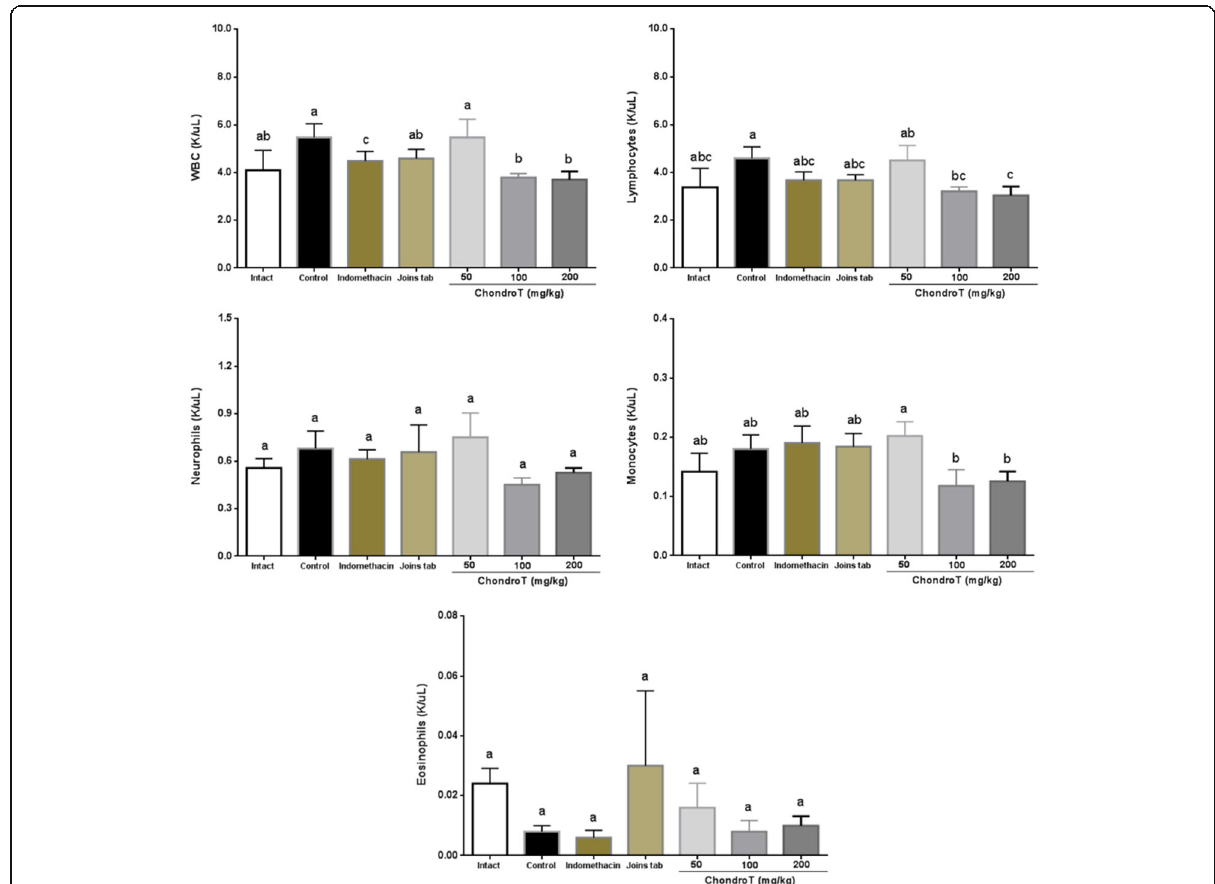
Fig. 5 Changes in the blood WBC, neutrophils, lymphocytes, monocytes, and eosinophils contents after ChondroT administration in collagenase-induced arthritis